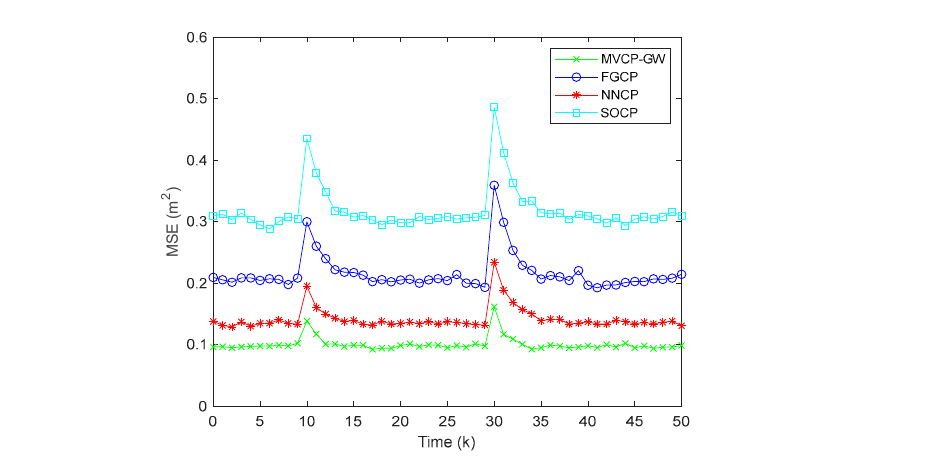
Figure 6. The relation diagram of positioning error MSE with time when encountering sudden error.